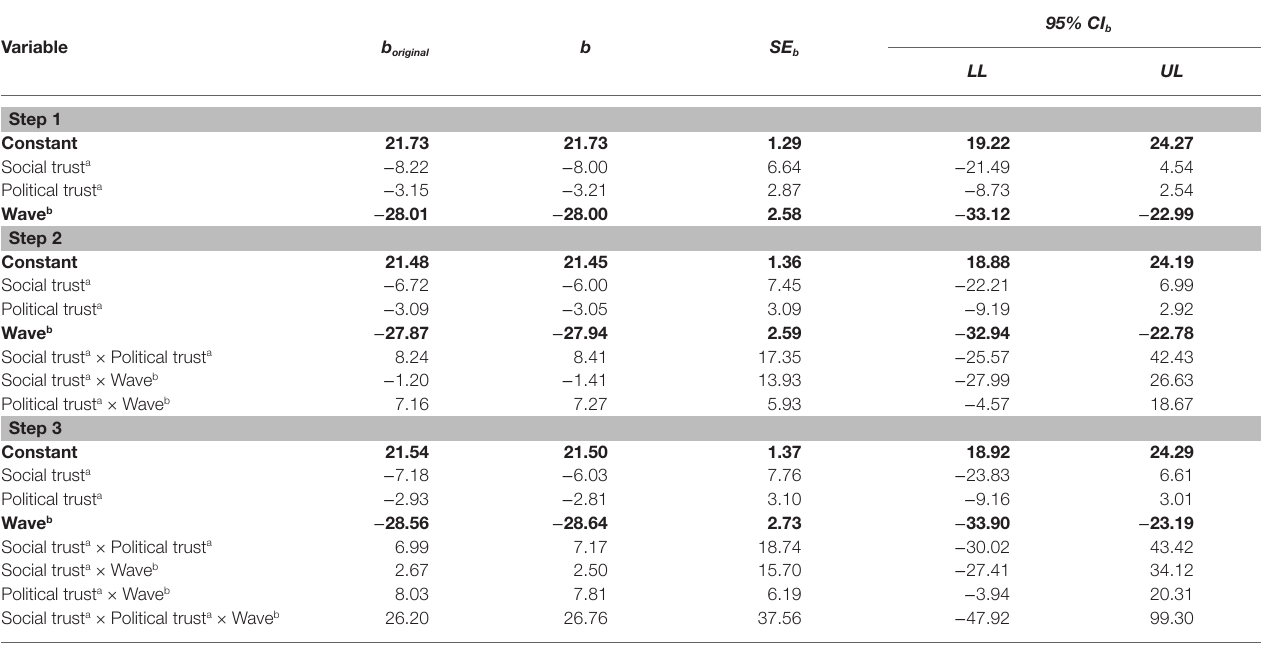
TABLE 5 | Bootstrapped hierarchical regression results on the dependent variable social distancing for Study 3.